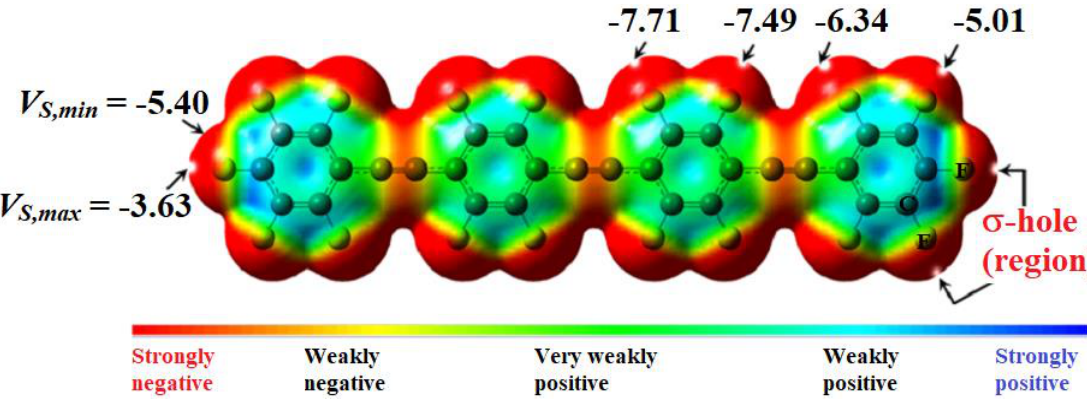
Figure 6. M062X/6-311++G(d,p) level 0.0010 a.u. isodensity mapped molecular electrostatic surface potential of BPEPE-F18. The maximum and minimum ( V S,max and V S,min , respectively) of MESP around some fluorine atoms in this compound are displayed, showing the presence of σ -holes with V S,max < 0 along the outermost extensions of the C–F bonds. Values are in kcal mol −1 .